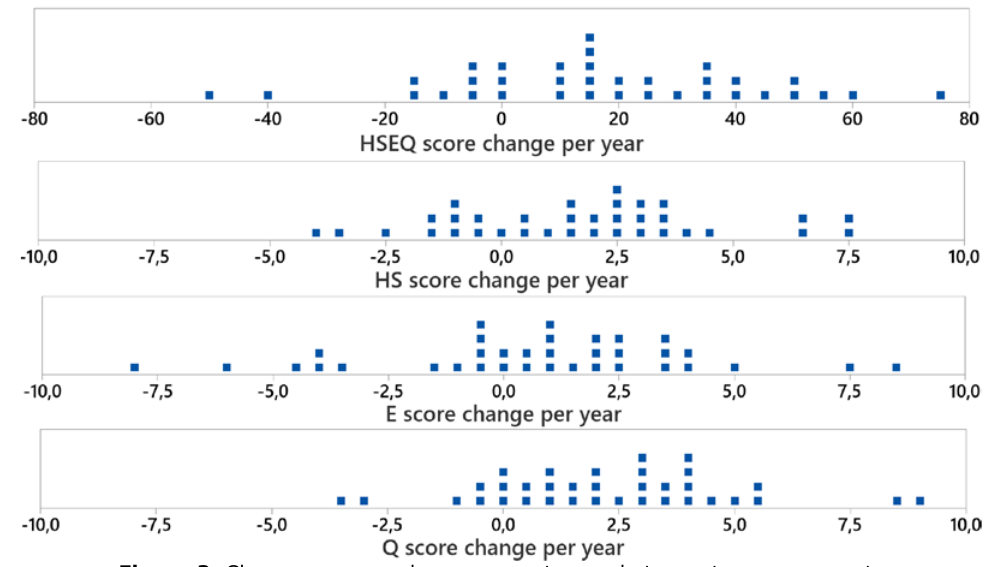
Figure 3. Changes per year in assessment score between two assessments